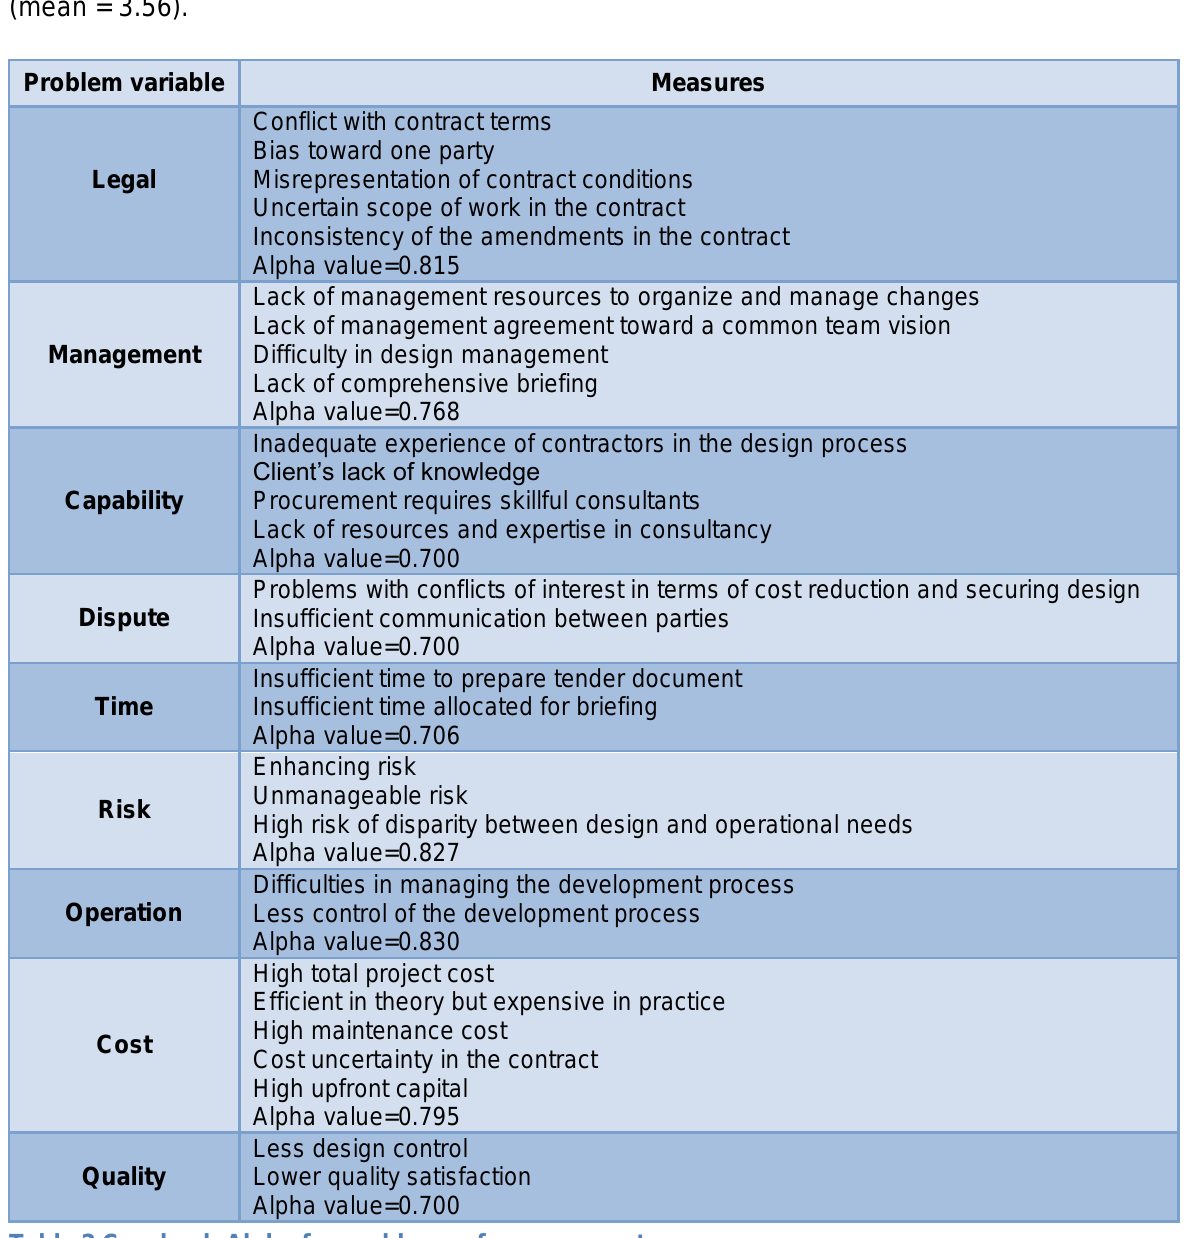
Table 2 Cronbach Alpha for problems of